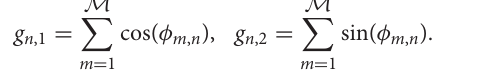
FIGURE 2 | Percentage of validity of Equation (10) over 1,000 random choices for the phases (uniformly and independently sampled between 0 and 2 π ), for each value of M . The red line depicts the average percentage of validity.